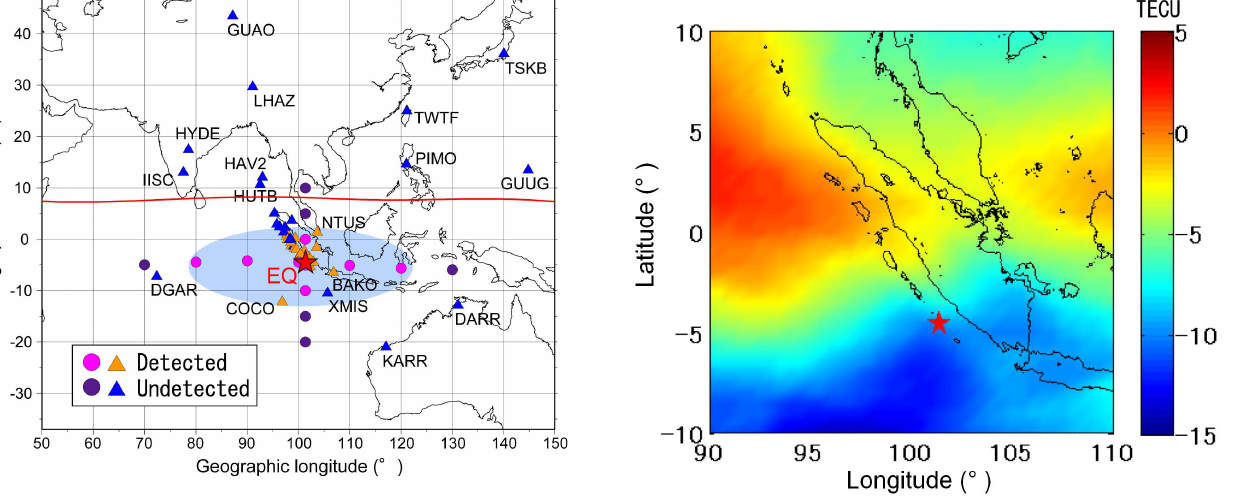
Fig. 8. Difference in the integrated electron content (altitudes of 100 to 700km) between the observed data and the reference data with the 15-day backward